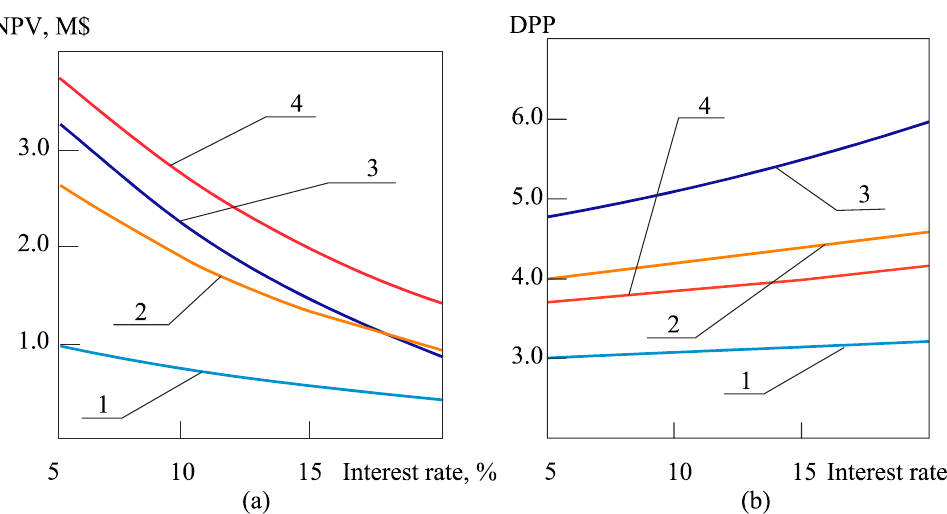
Figure 12. Comparison of the main economic indicators for the projects of the EB production unit retrofit, depending on the value of the Interest rate: ( a ) For the net present value; ( b ) discounted payback period. 1—Pinch retrofit; 2—integration of a heat pump between columns K-62 and K-52 (case 1); 3—integration of the heat pump with the column K-62 (case 2); 4—combining Pinch retrofit and option 1.